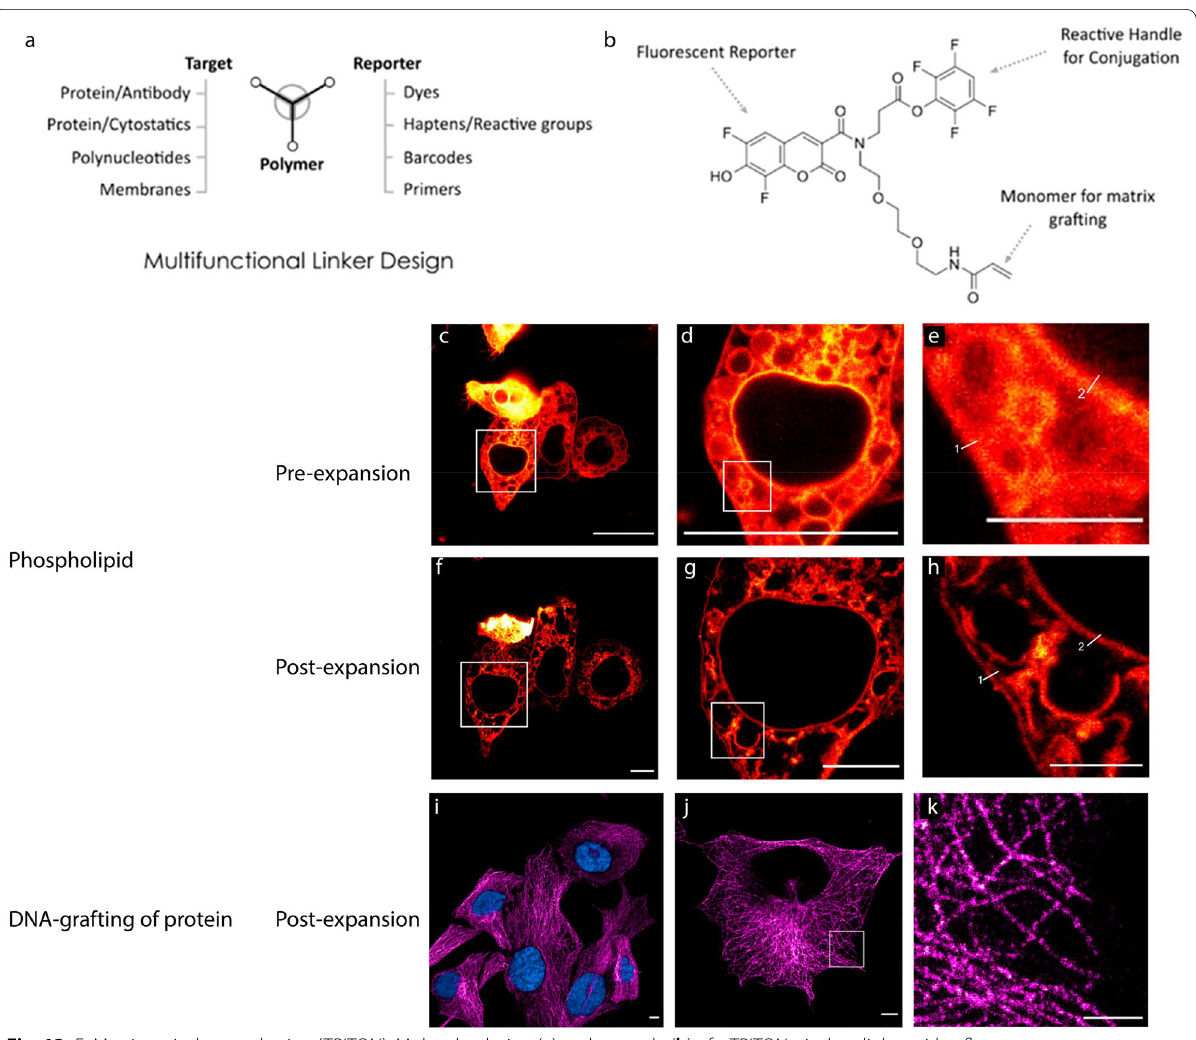
Fig. 13 ExM using trivalent anchoring (TRITON). Molecular design ( a ) and example ( b ) of a TRITON trivalent linker with a fluorescent reporter (Pacific Blue), reactive tetrafluorophenyl (TFP) ester for amine conjugation, and acrylamide monomer for grafting to the expansion microscopy polymer. c – h Expansion of HeLaP4 phospholipid membranes through lipid conjugation to a fluorescent TRITON trivalent linker. c – e Pre-expansion image ( c ) with magnified views ( d , e ) of the boxed areas. Scale bars: 25 μm ( c , d ) and 5 μm ( e ). f – h Post-expansion image ( e ) with magnified views ( g , h ) of the boxed areas. Scale bars: 7.8 μm (25 μm) ( f , g ) and 3.03 μm (10 μm) ( h ). i – k Immunostaining of α-tubulin of HeLa cell via direct grafting of oligo-conjugated secondary antibody and fluorescent oligo-based readout post-expansion. i Two-color imaging with a nuclear DAPI staining (cyan) and immunostaining of α-tubulin, visualized with readout oligo (Cy5,magenta). j The same staining as i but with the DAPI-channel removed to show the high signal-to-noise ratio and low background staining in the nucleus. k Magnified view of the boxed area in j . Scale bars: 3.03 μm (10 μm) ( i , j ) and 1.52 μm (5 μm) ( k ). (Reprinted/adapted with the permission from Wen et al. [65]. Copyright 2020 American Chemical